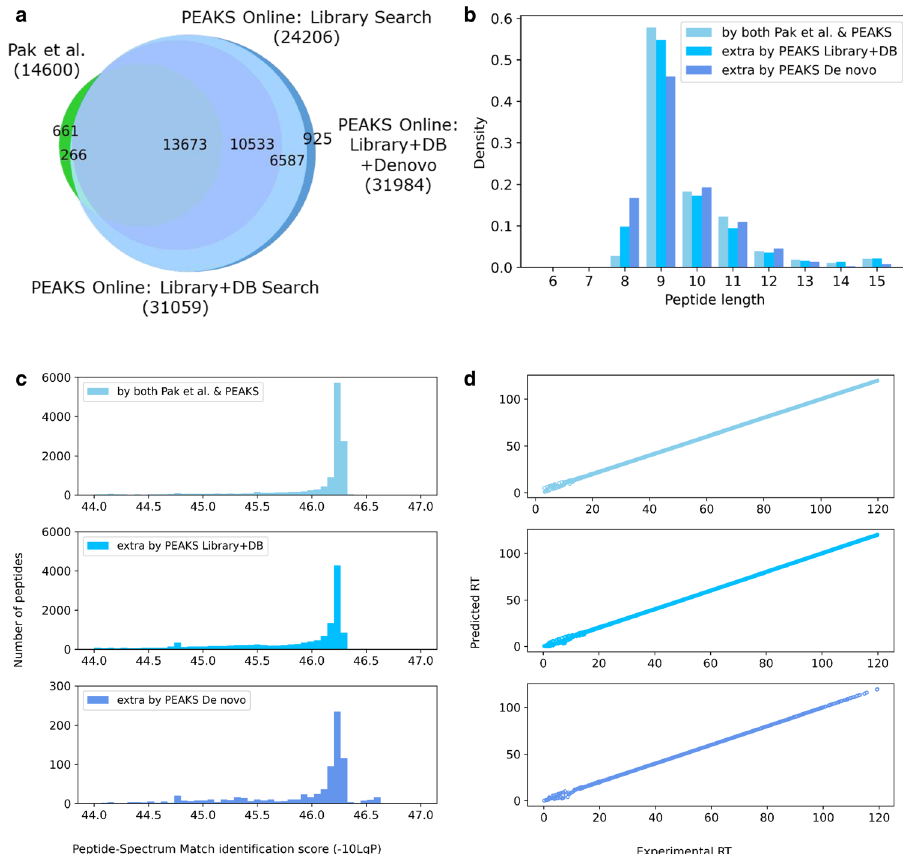
Fig. 3 Integrated work fl ow for DIA analysis of the immunopeptidomics sample RA957. a Venn diagram of the peptides identi fi ed by PEAKS Online spectral library search, database search, and de novo sequencing versus the results reported by Pak et al. 21 . b The length distributions of the identi fi ed peptides. c The distributions of the peptide-spectrum match (PSM) identi fi cation scores reported by PEAKS Online (named “ -10LgP ” ). d The distributions of experimental retention times (RTs) versus predicted RTs of the identi fi ed peptides. The colors follow the legends in c